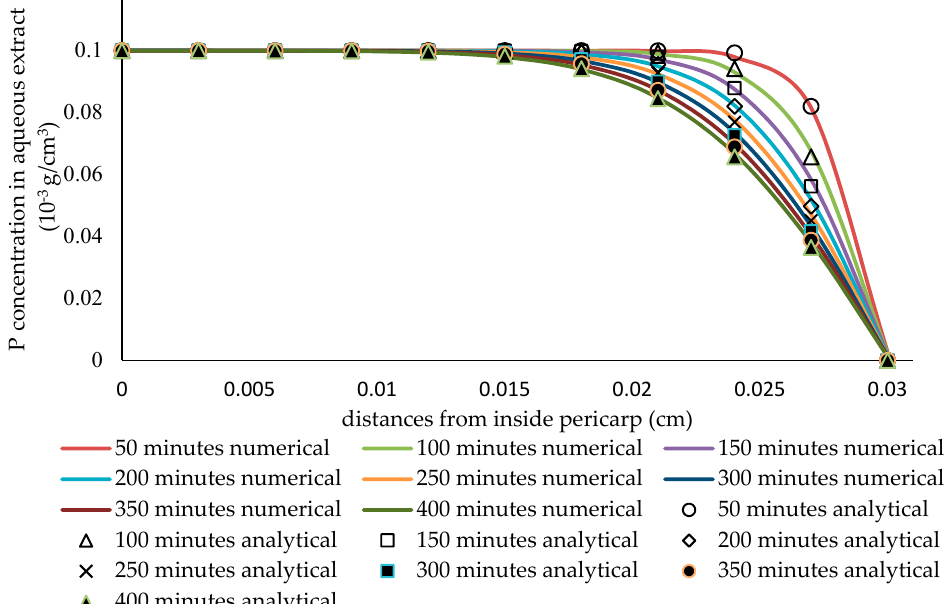
Figure 7. The comparison of the analytical solution and the numerical solution under the conditions of a very thick slab and very slow diffusivity.